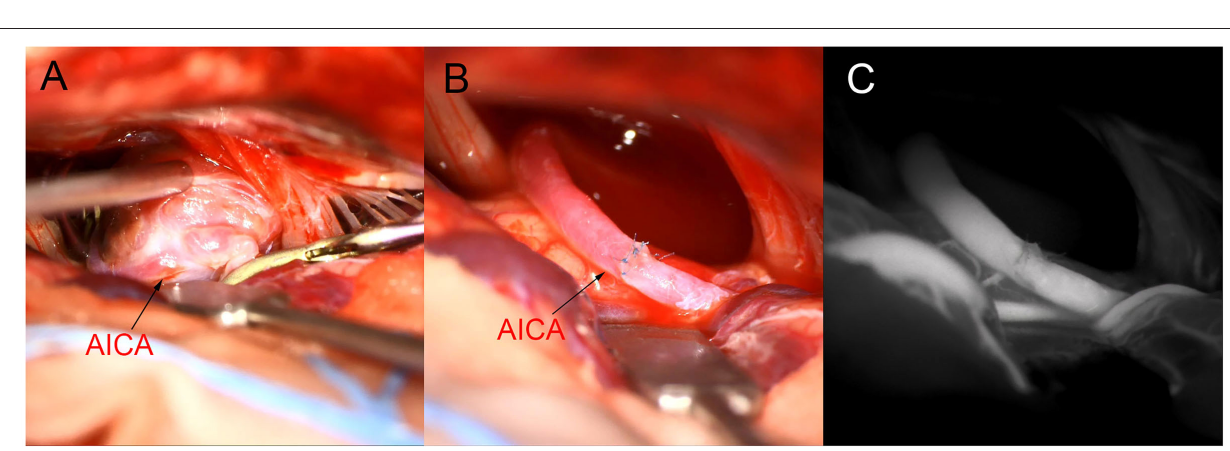
FIGURE 2 | Schematic diagram of operation. Right AICA aneurysm located in a2 segments, intracranial artery anastomosis in situ was perform after trapping and resection. (cAICA, caudal trunk of AICA; mAICA, main trunk of AICA; rAICA, rostral trunk of AICA; a2, lateral pontine segments of AICA).